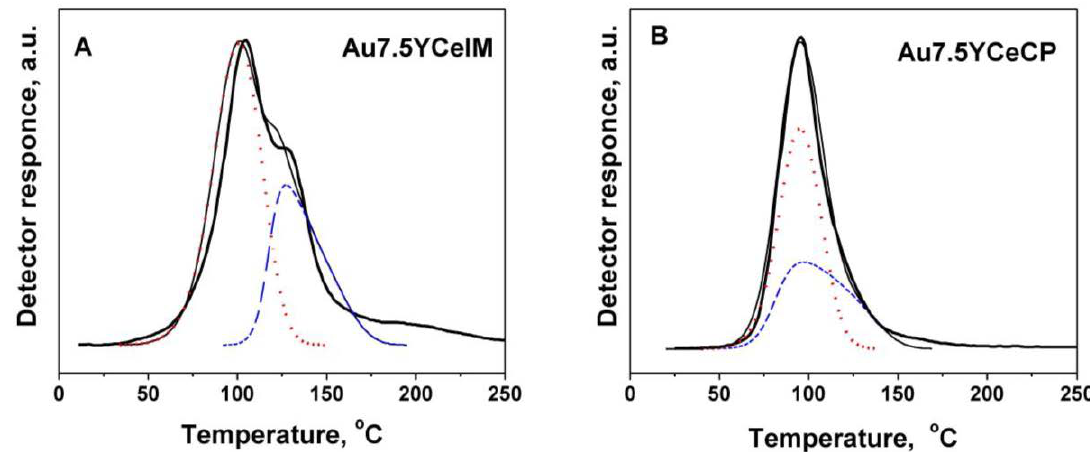
Figure 6. TPR profiles of Au7.5YCeIM ( A ) and Au7.5YCeCP catalysts ( B ): full lines—experimental curve (bold) and fitted calculated curve, dotted lines—peaks corresponding to the individual reduction processes.